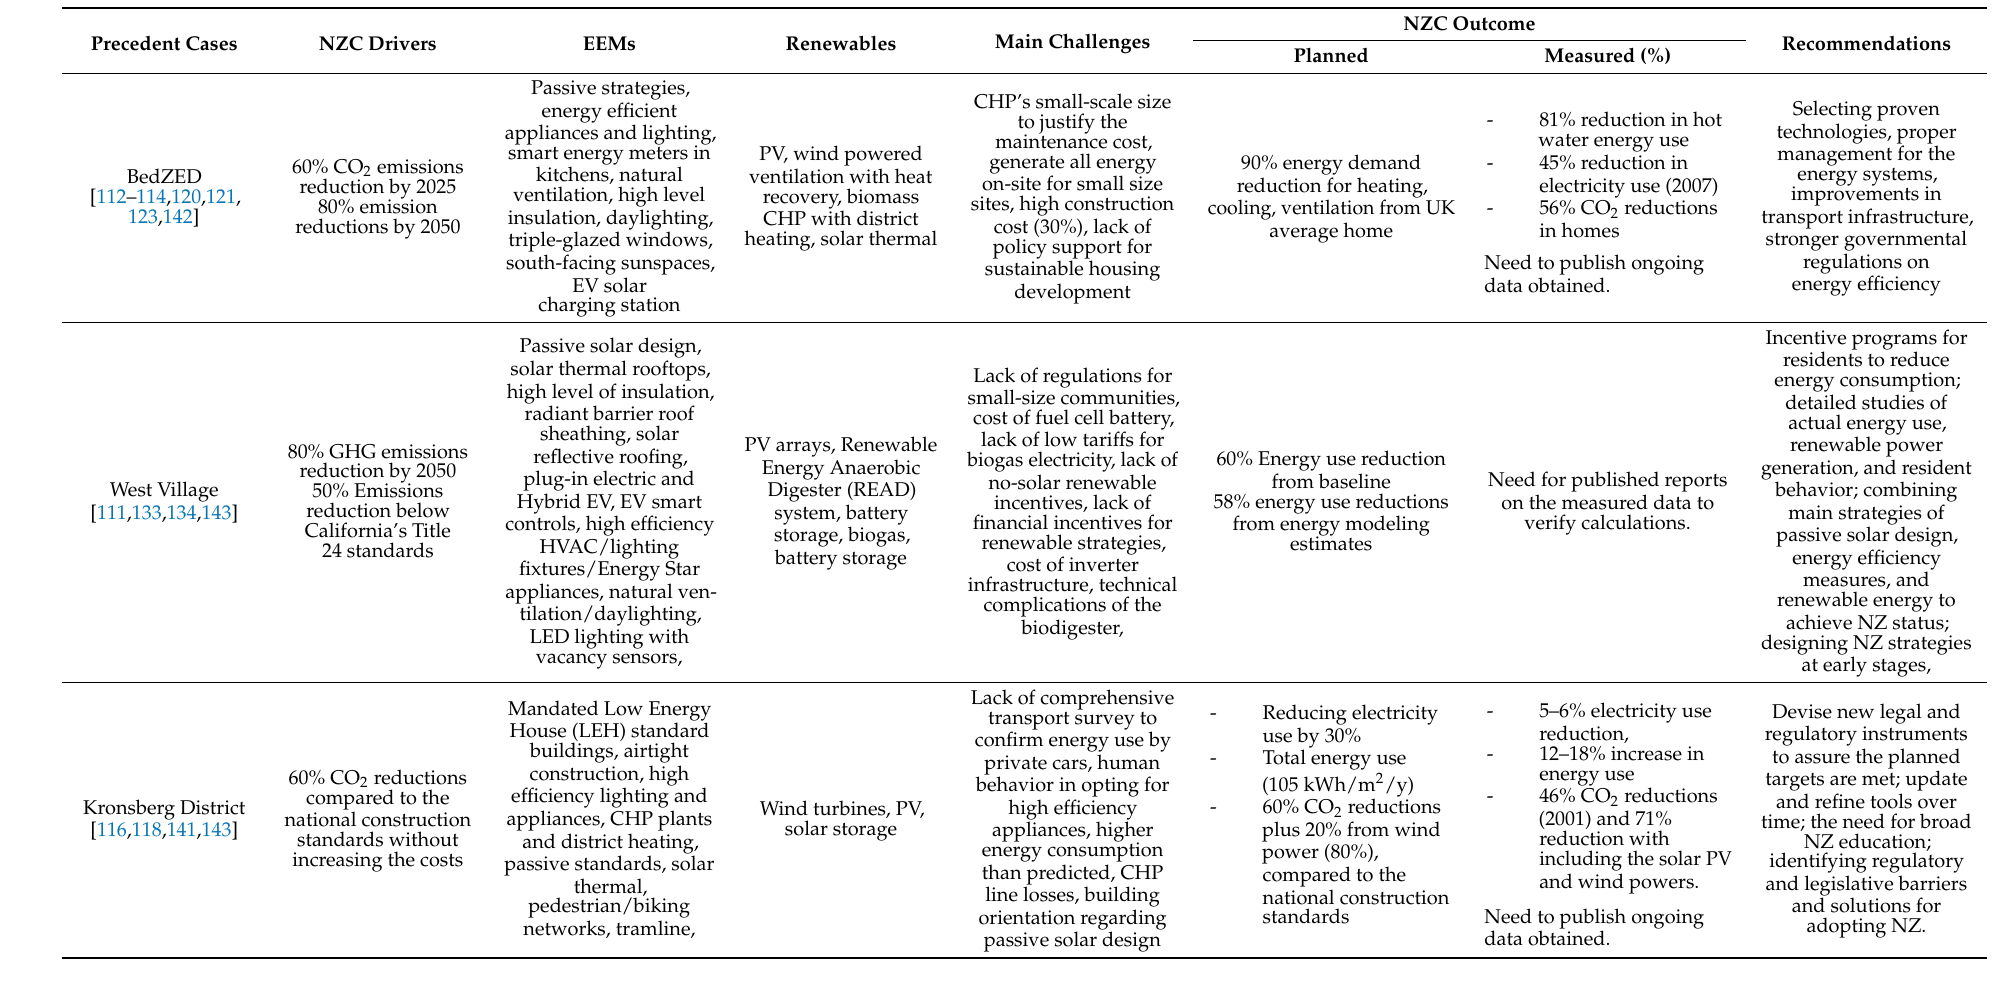
Table 8. Analysis of NZC variation, strategy, and requirements from three preceding cases